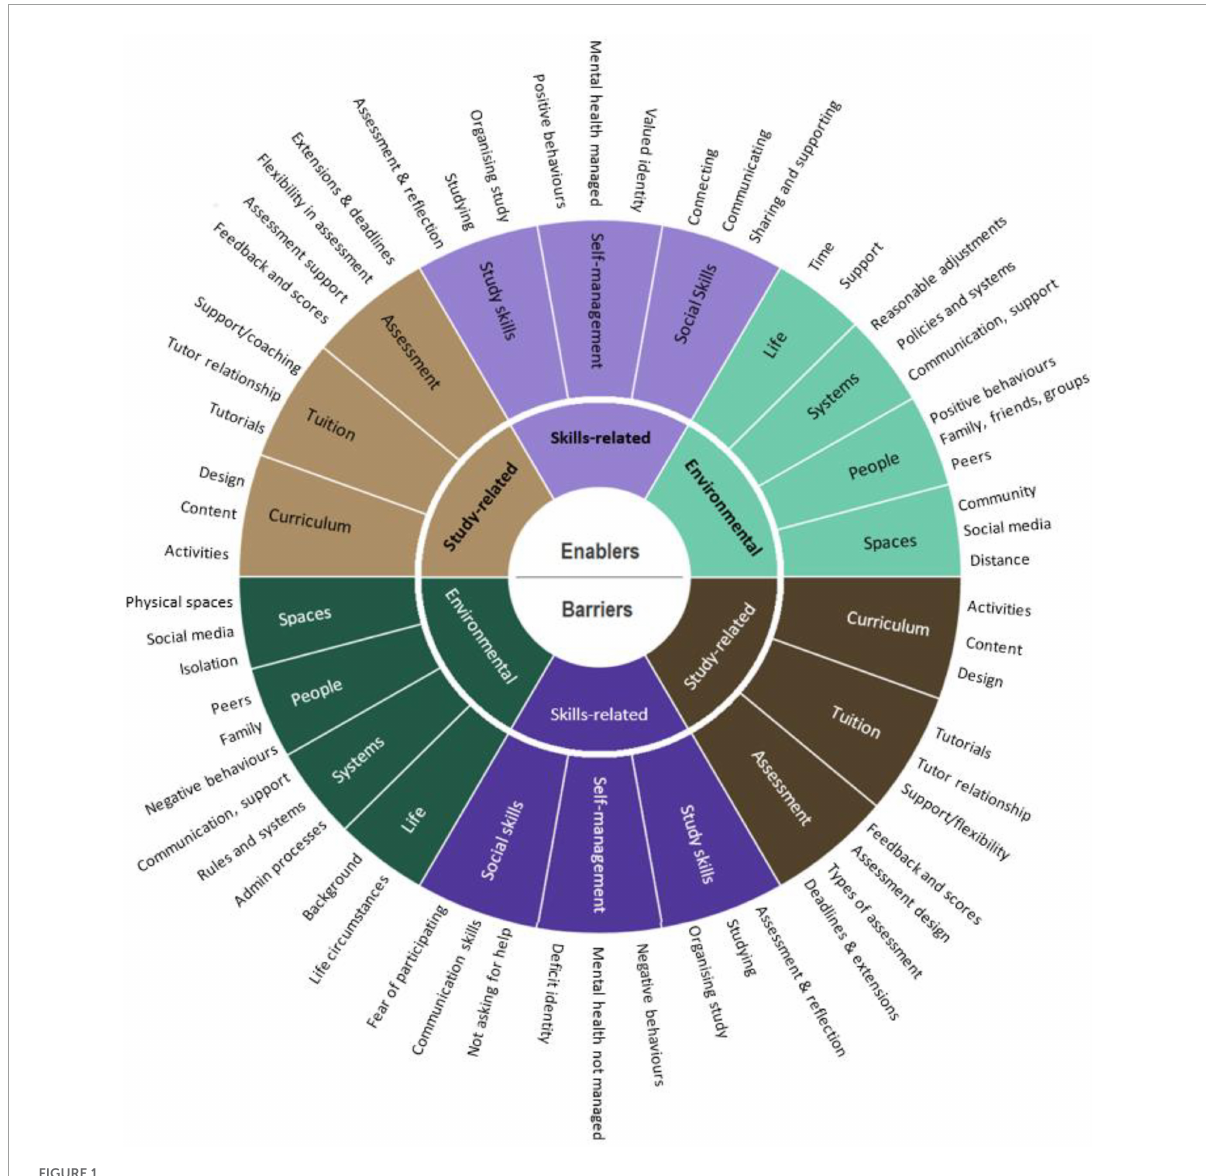
FIGURE1 Taxonomy of barriers and enablers to mental wellbeing (Lister et al.,